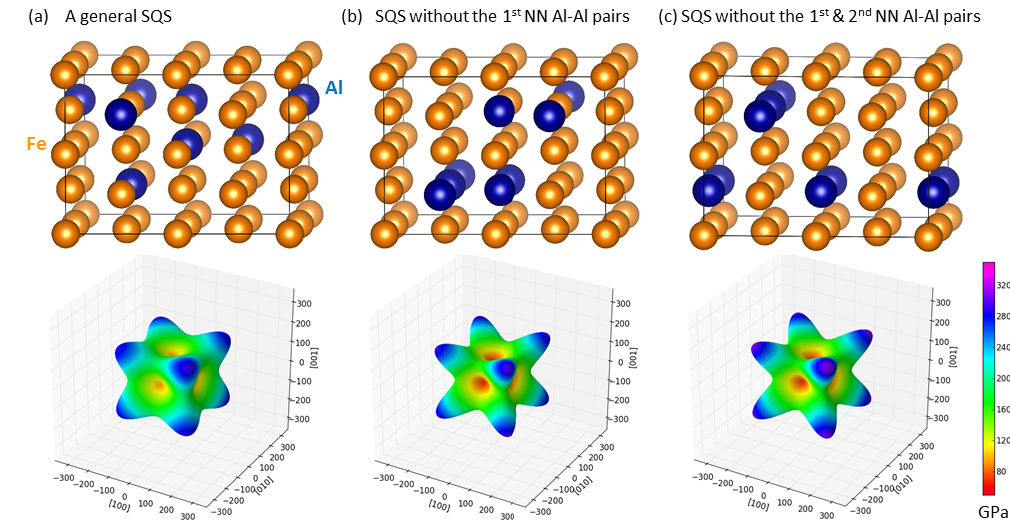
Figure 5. Upper row: Schematic visualization of the 32-atom computational supercells with chemical composition Fe 82.25 Al 18.75 (26 atoms of Fe and 6 atoms of Al) used for modeling of the Fe-Al phase of the matrix. The supercells differ in the distribution of atoms (see the text for details). The left variant is a distribution when all atoms form a complete disordered solid solution modeled by a general special quasi-random structure, the A2 case ( a ). The middle variant is a B2-type SQS with all the Al atoms on only one of the two sublattices, i.e., there are no 1st NN Al-Al pairs ( b ). The right figure shows a D0 3 -type SQS with the Al atoms on only one of the three sublattices—there are no 1st and 2nd Al-Al NN pairs ( c ). Lower row: Visualization of anisotropic elastic properties for each atomic distribution in the form of directional dependences of the Young’s modulus (visualized by the SC-EMA software